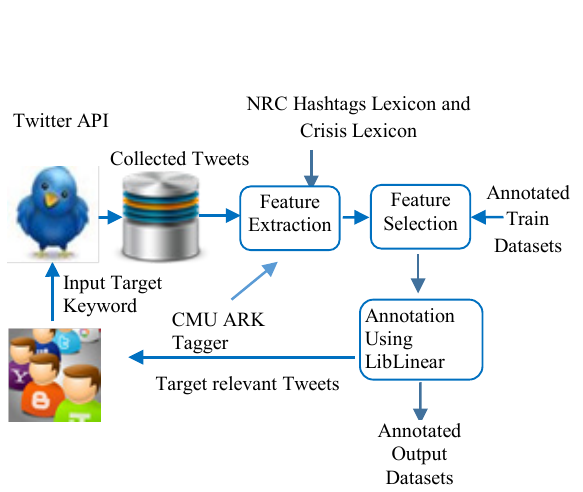
Fig. 1. Architecture of the Proposed Tweets Monitoring System